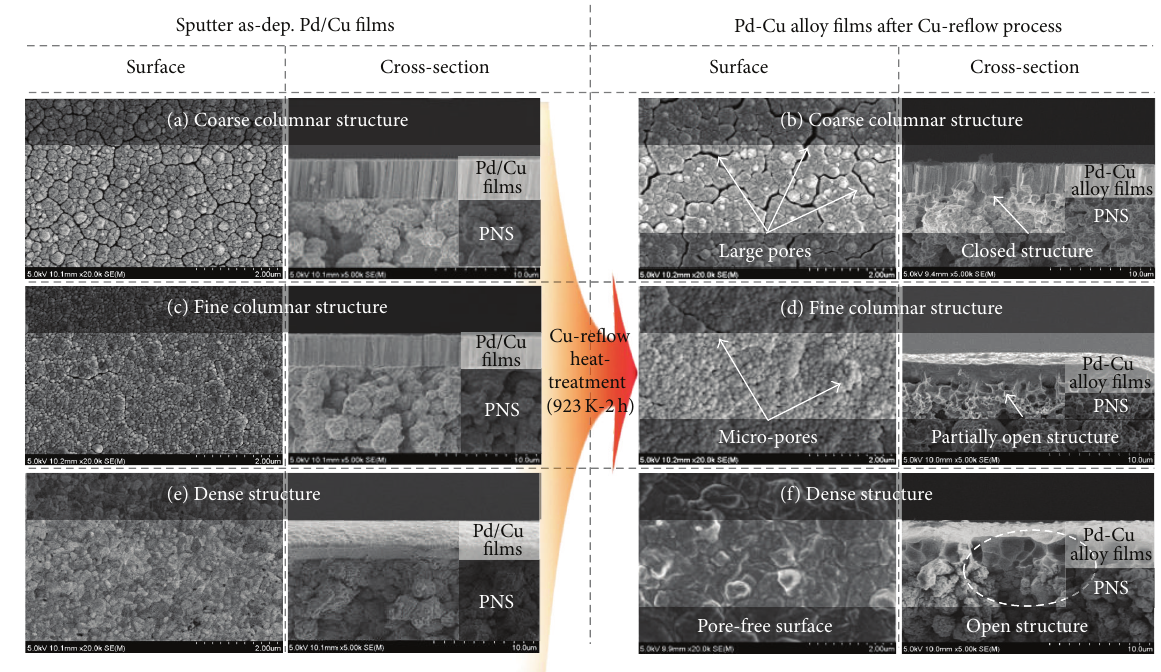
Figure 3: Surface and cross-sectional FE-SEM images of sputter as-deposited Pd/Cu and Pd-Cu alloy films after the Cu-reflow process for various sputtering variables: (a), (c), (e) sputter as-deposited films; (b), (d), (f) Pd-Cu alloy films after heat